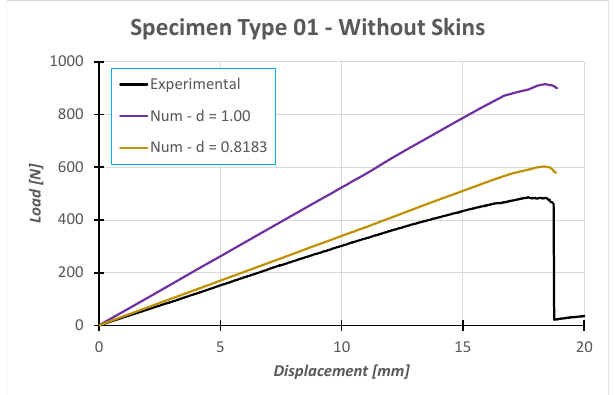
Figure 11. Experimental-numerical comparison using the nominal diameter and the one evaluated on the measured mass.